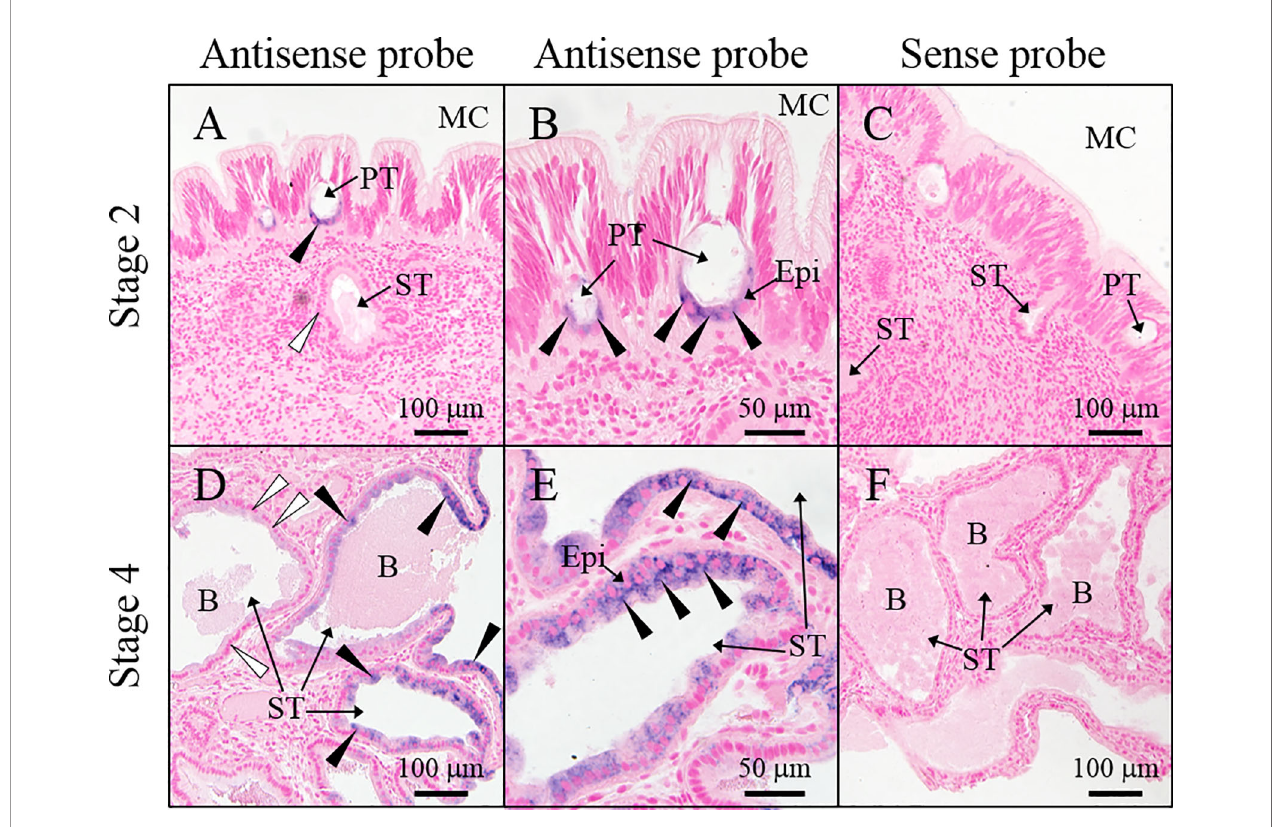
FIGURE 6 | Location of slPgrp2 transcripts in ANG. (A, B) slPgrp2 transcripts were detected in epithelial cells of primary tubules in the ANG using an antisense probe in immature female squid (stage 2). (C) Background staining was evaluated using a sense probe for slPgrp2 in immature female squid (stage 2). (D, E) slPgrp2 transcripts were detected with an antisense probe in epithelial cells of secondary tubules of ANG in mature female squid (stage 4). (F) Background staining was evaluated using a sense probe for slPgrp2 in mature female squid (stage 4). Black arrowhead denotes slPgrp2 signal, and white arrowhead denotes areas without slPgrp2 signal in epithelial cells. B, bacteria; Epi, epithelial cells; MC, mantle cavity; PT, primary tubule; ST, secondary